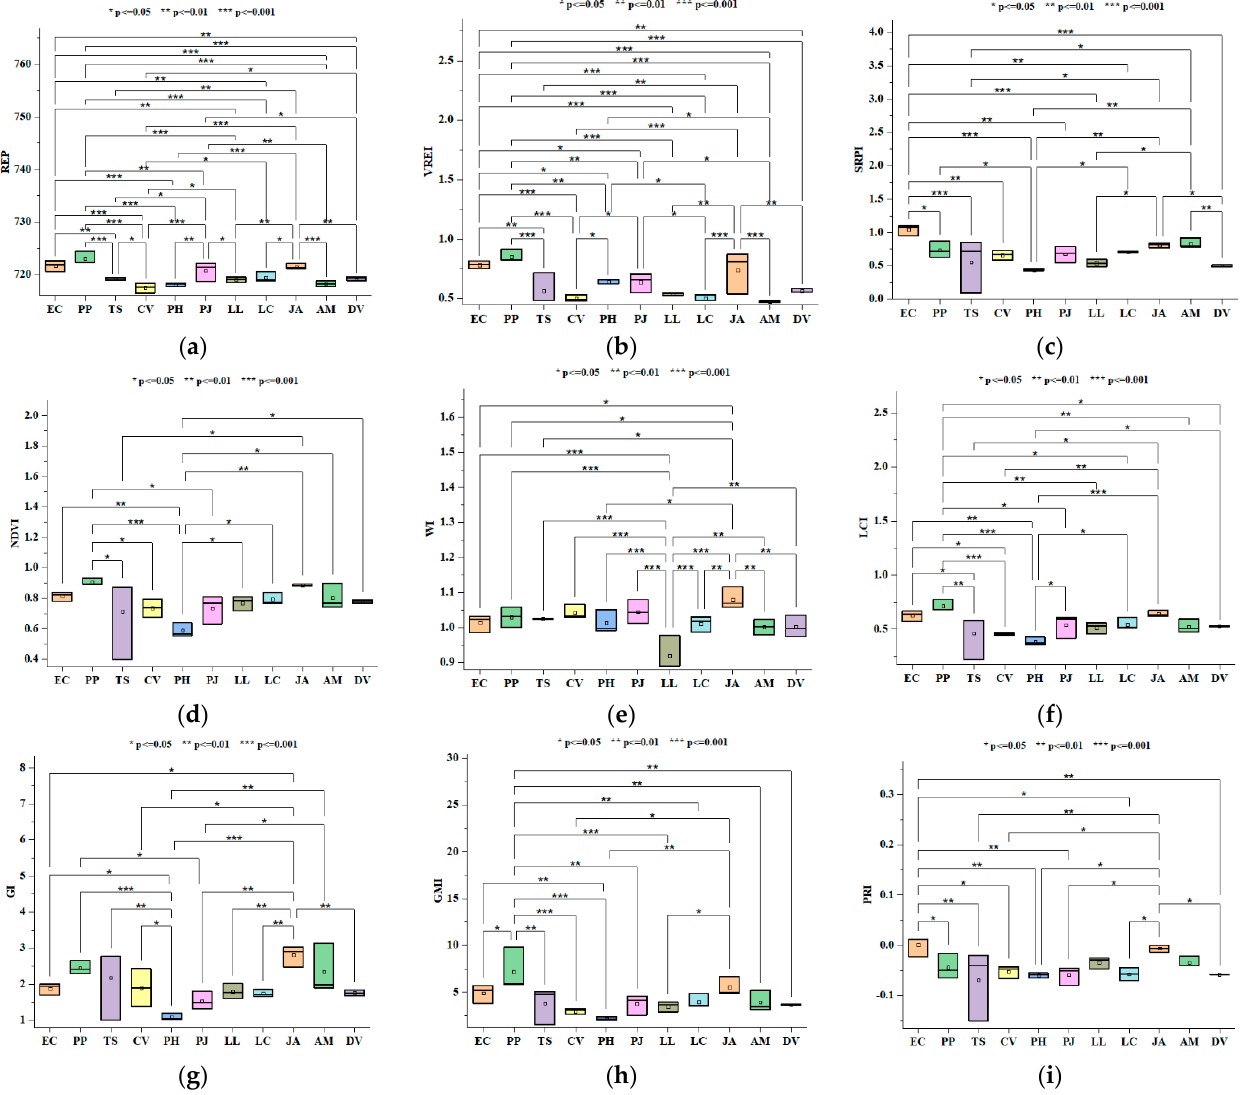
Figure 5. Pairwise comparison of significant spectral indices REP ( a ) VREI ( b ) SRPI ( c ) NDVI ( d ) WI ( e ) LCI ( f ) GI ( g ) GMI ( h ) and PRI ( i ). The lines above boxplots indicate only the significant pairs at 0.05 (*), 0.01 (**) and 0.001 (***) significance level among different pairs of plant species. The abbreviations of plant species on the x axis are mentioned in Table 2.